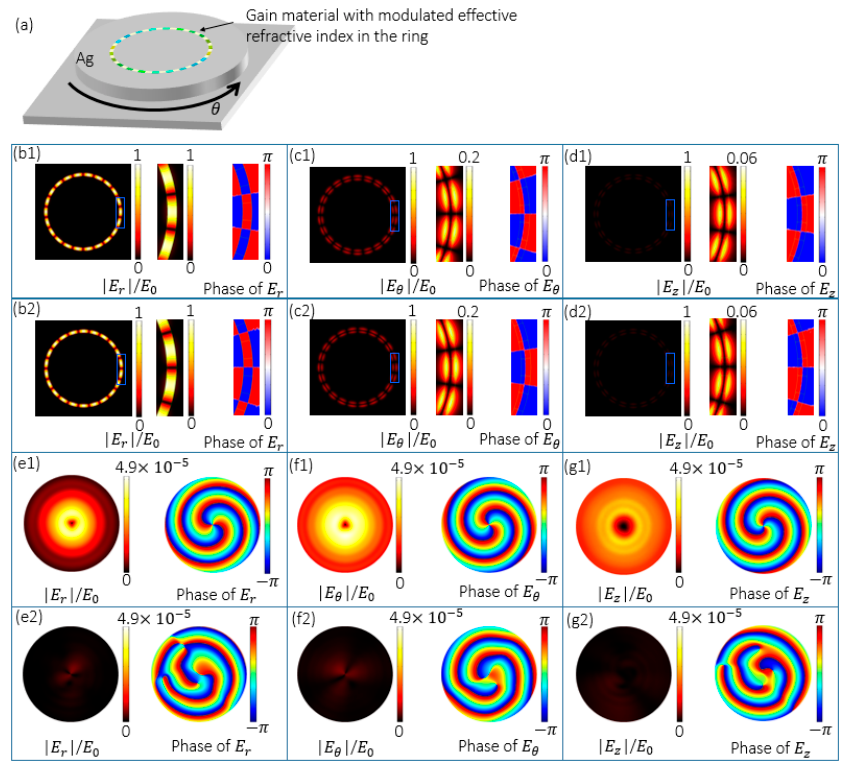
Figure 1. The cavity mode and the emitted mode of the OAM laser for l = 11. ( a ) Schematic of an OAM laser. The z = 0 is at the bottom of the InGaAsP ring, and the ( x = 0, y = 0 ) is at the center of the ring. ( b1 )–( g1 ), mode 1 inside the cavity [( b1 )–( d1 )] and the corresponding emission mode [( e1 )–( g1 )]. ( b2 )–( g2 ). Mode 2 inside the cavity [( b2 )–( d2 )] and the corresponding emission mode [( e2 )–( g2 )]. ( b1 ),( b2 ), the intensity distributions | E r | / E 0 of the radial component of the electric field inside the cavity (the | E r | / E 0 and the phase of E r in the area marked by rectangular box is also presented in the enlarged figures). ( c1 ),( c2 ), the intensity distributions | E θ | / E 0 of the azimuthal component of the electric field inside the cavity (the | E θ | / E 0 and the phase of E θ in the area marked by rectangular box is also presented in the enlarged figures). ( d1 ),( d2 ), the intensity distributions | E z | / E 0 of the z -component of the electric field inside the cavity (the | E z | / E 0 and the phase of E z in the area marked by rectangular box is also presented in the enlarged figures). ( b1 )–( d1 ), ( b2 )–( d2 ) are the mode properties at z = h InGaAsP /2. ( e1 )–( g1 ), ( e2 )–( g2 ) are in the cross section (the radius of the area is 5000 nm) of the emission modes at 2 µ m above the upper surface of the cavity. E 0 is the maximum of the | E r | in the ( b1 ). The green lines in the enlarged figures are the boundaries of different sections. The q = 2 is used. The eigenfrequencies of the two modes are 1.9999 × 10 14 + i 6.25 × 10 11 Hz and 2.0031 × 10 14 + i 9.45 × 10 11 Hz, respectively. These results are calculated by the Comsol Multiphysics.